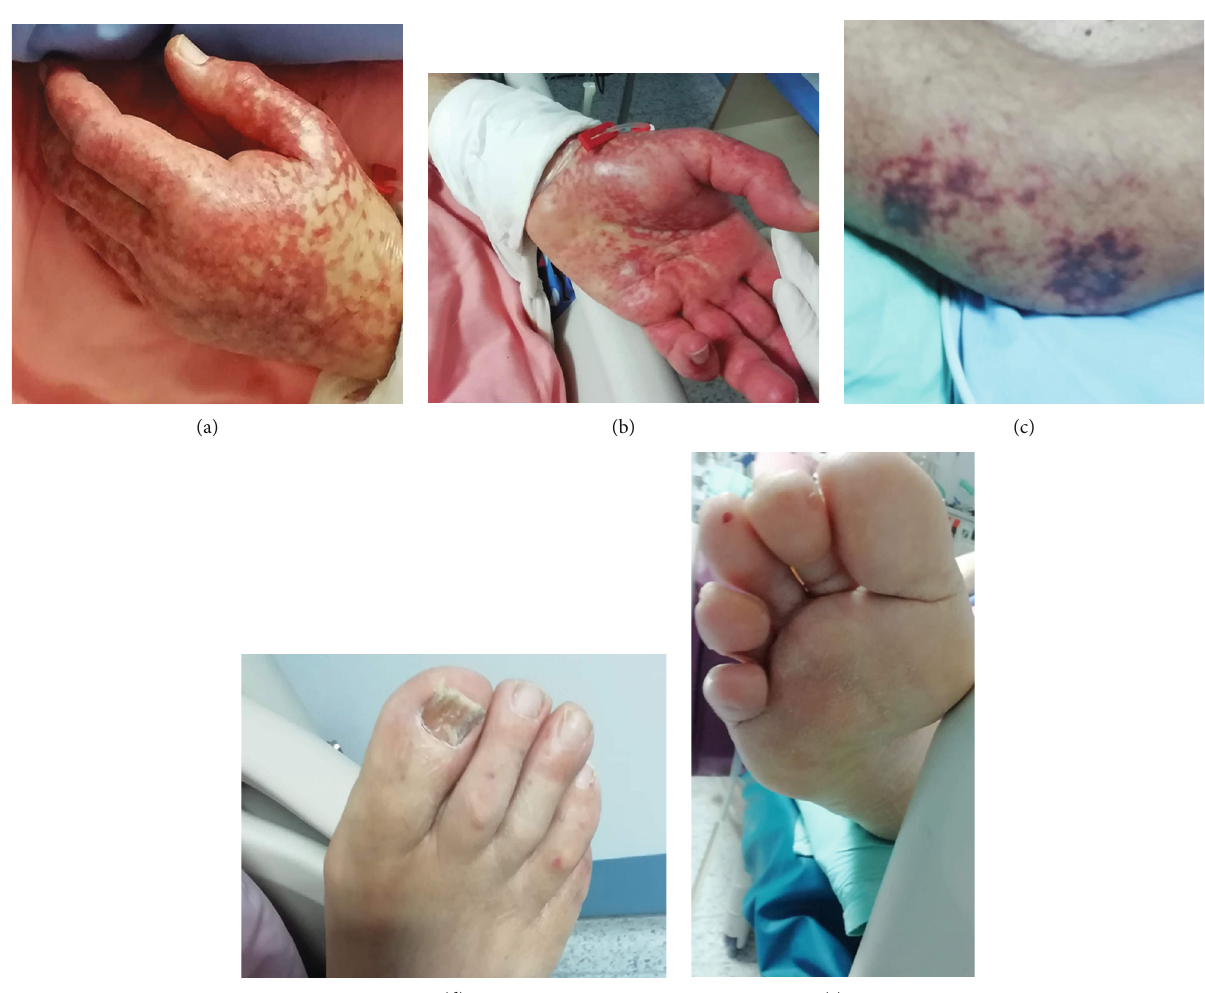
Figure 1: Initial lesions of retiform purpura or livedo on dorsal (a) and palmar (b) area of hands, and elbows (c). Scattered petechial lesions on toes on dorsal (d) and plantar (e) area of toes.